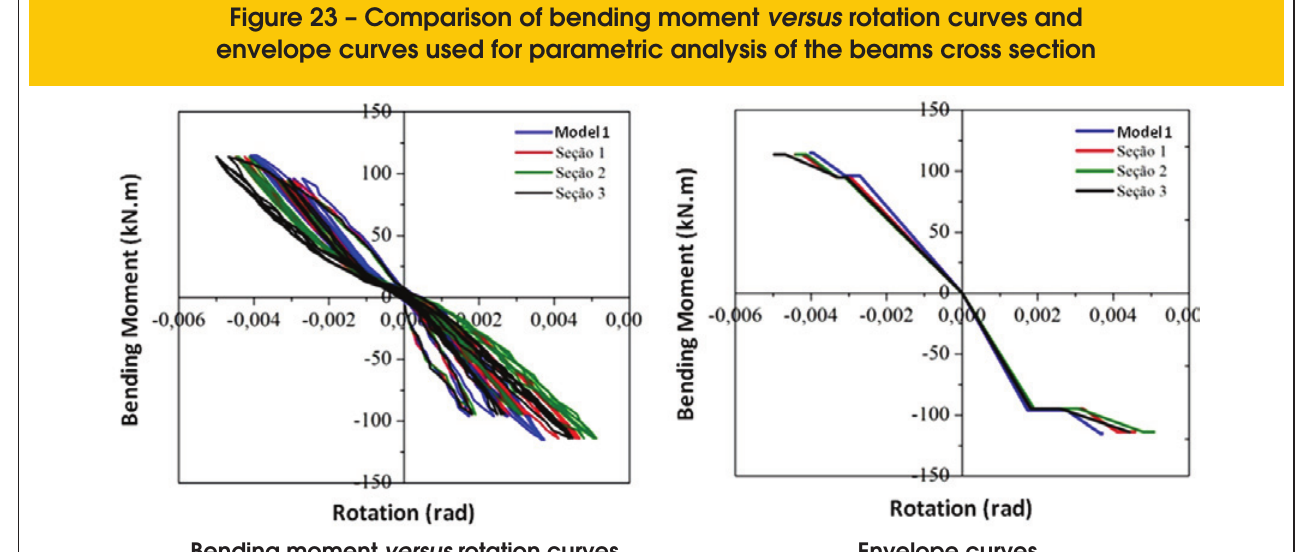
Figure 23 – Comparison of bending moment versus rotation curves and envelope curves used for parametric analysis of the beams cross section